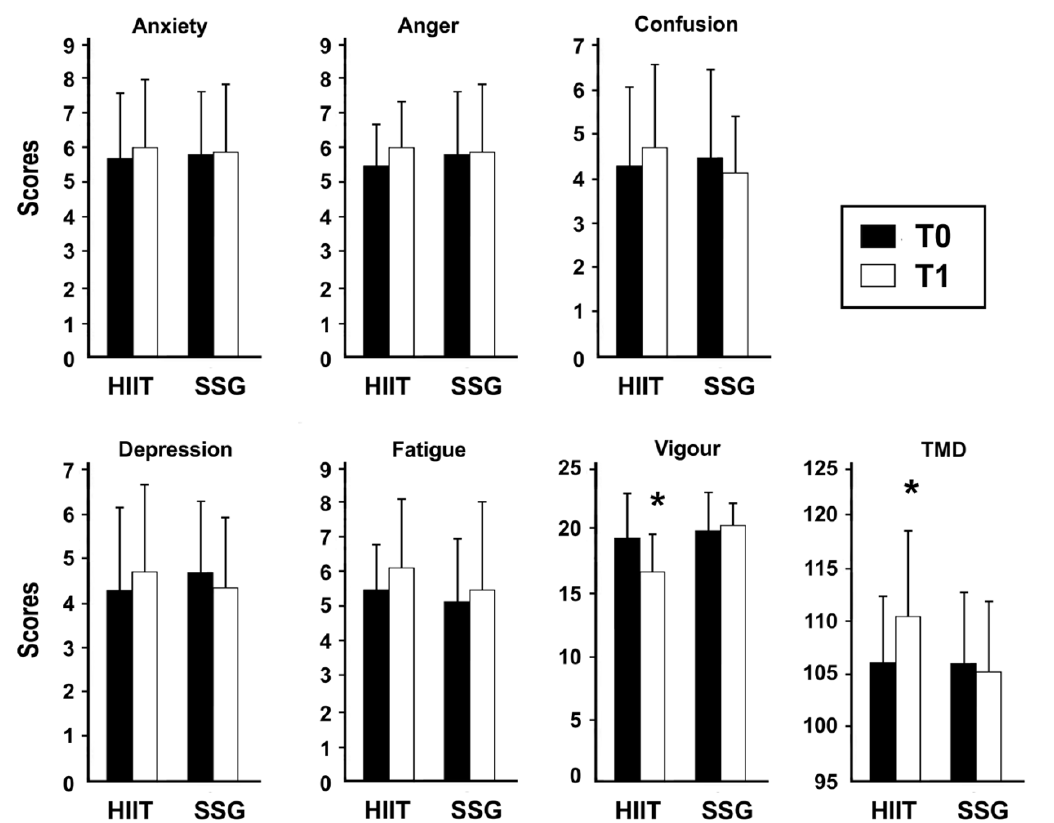
Figure 3. POMS scores for high intensity interval training (HIIT) and small-sided games (SSG) measured before and after the 6-week training program. TMD: total mood disorder. * Significant difference between before (T0) and after (T1) training for each group.